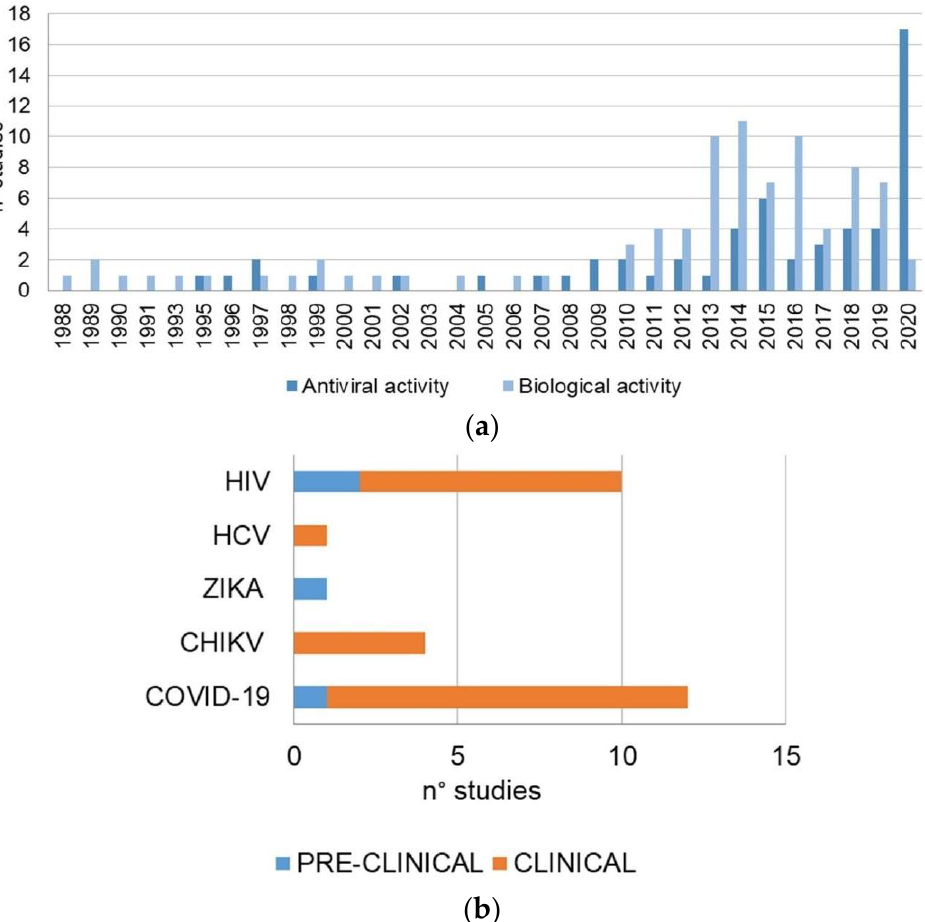
Figure 3. Distribution of the selected studies by year of publication focusing on antiviral activity or other biological activities. ( a ) Distribution, and the total number of preclinical and clinical studies per virus ( b ) HIV = herpes virus simple, HCV = hepatitis C virus, ZIKA = Zika virus, CHIKV = Chikungunya virus, COVID-19 = new Coronavirus Disease 2019; n° = number.